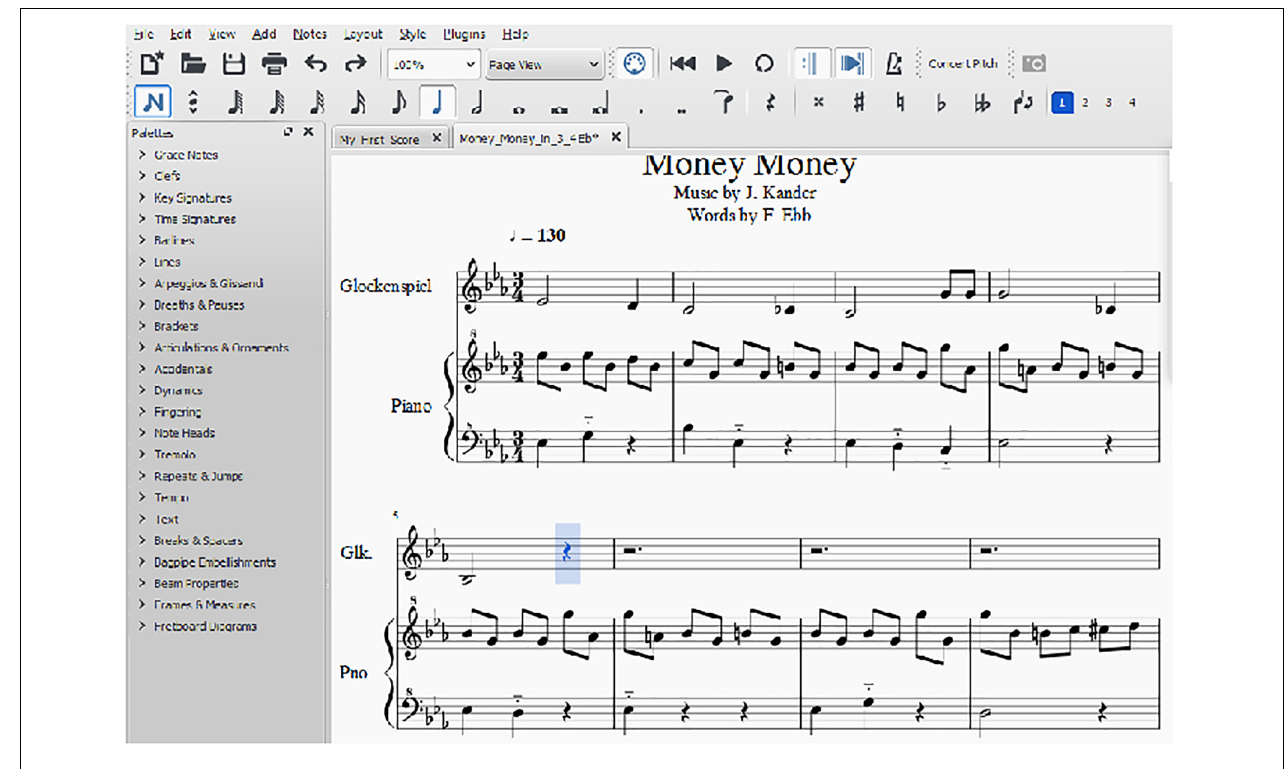
FIGURE 10 | Re-writing a melody in 3/4 time on a given accompaniment.